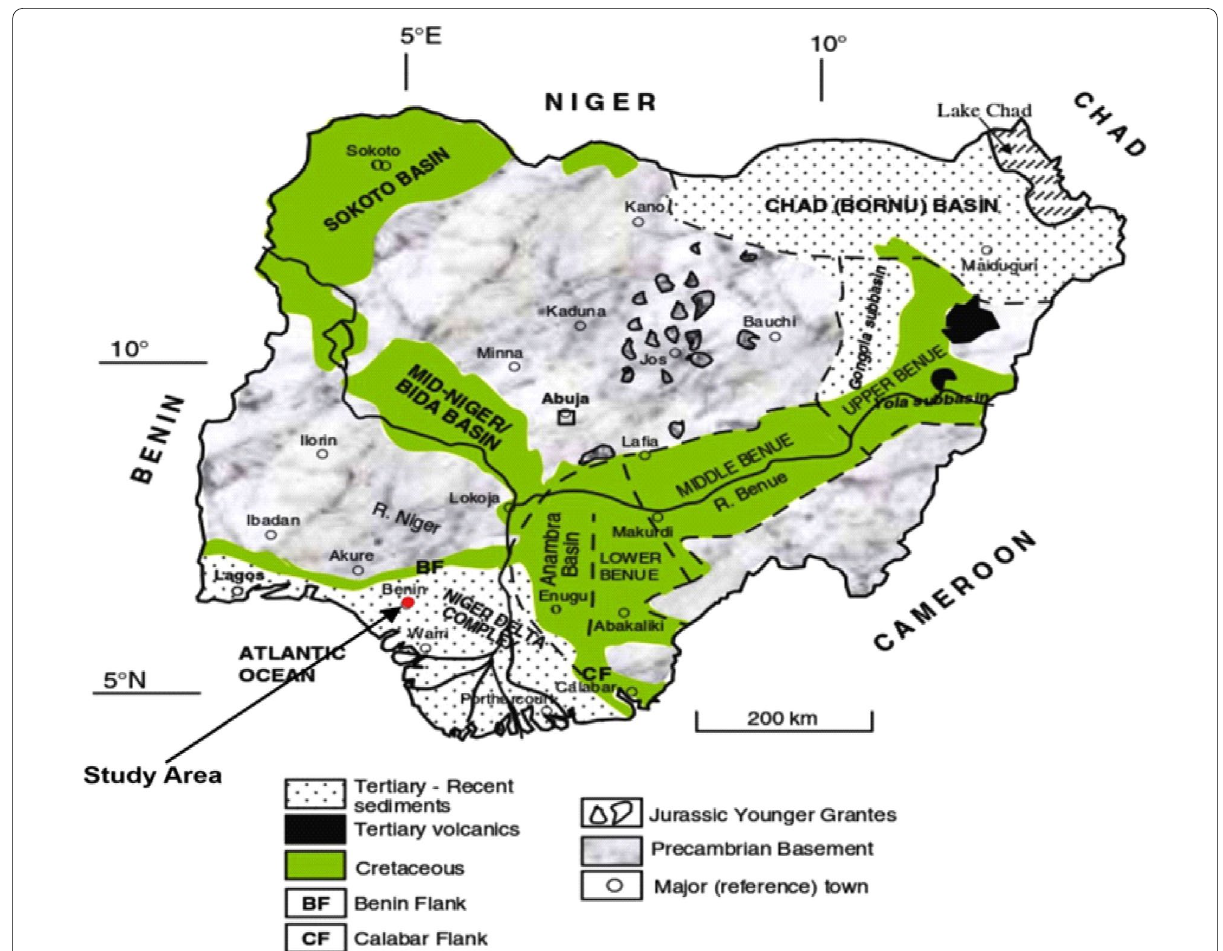
Fig.1 Map of Nigeria showing the study area (Obaje et al.